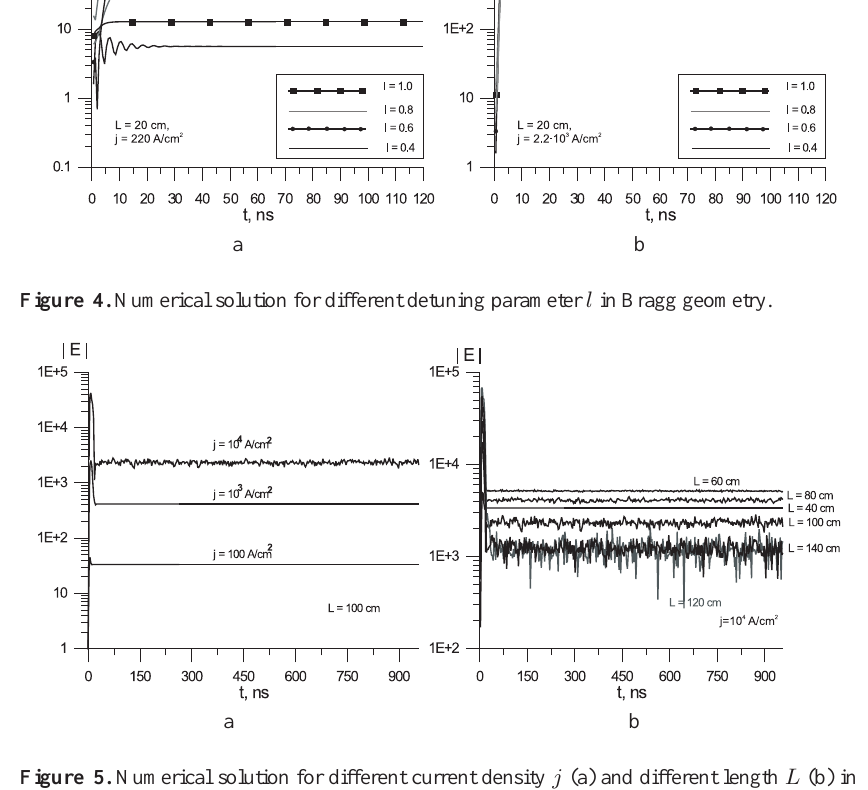
Figure 5. Numerical solution for different current density j (a) and different length L (b) in Laue